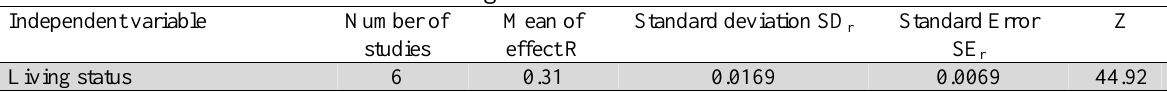
The results of statistical test between living status and failure in education Independent variable Number of